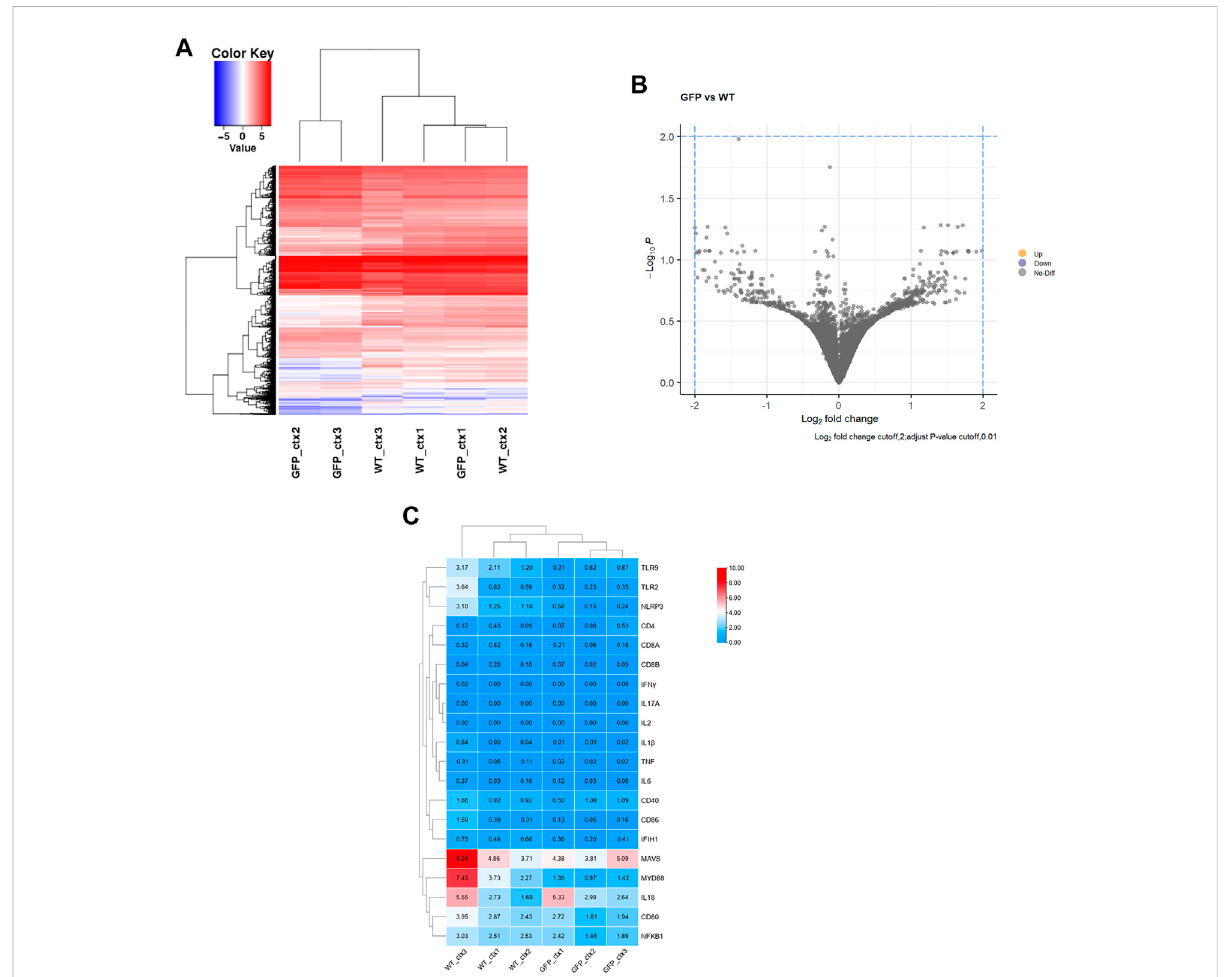
FIGURE 7 Transcriptome analysis of the intravenous AAV9-injected pig cortical tissues. (A) Heatmap of differential gene expression, blue and red color intensities represent gene downregulation and upregulation, respectively. (B) GFP vs. WT differential gene volcano plot, Log 2 fold change cutoff,2; adjust p -value cutoff,0.01. (C) Heatmap of expression of 20 common genes associated with in fl ammatory